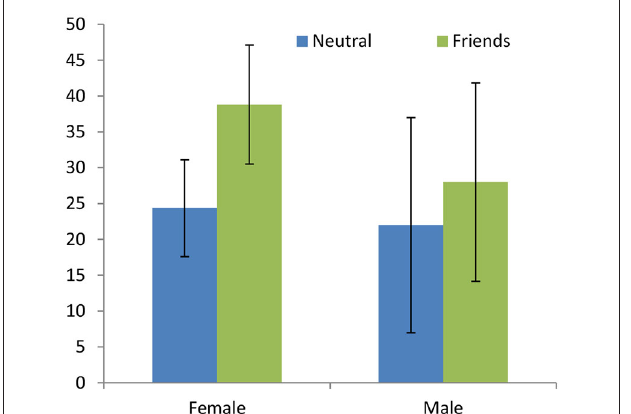
FIGURE 1 | Giving in the Dictator Game (DG; data: Brañas-Garza et al., 2010) . Reducing the social distance between the Dictator and the Recipient affects females but not males.